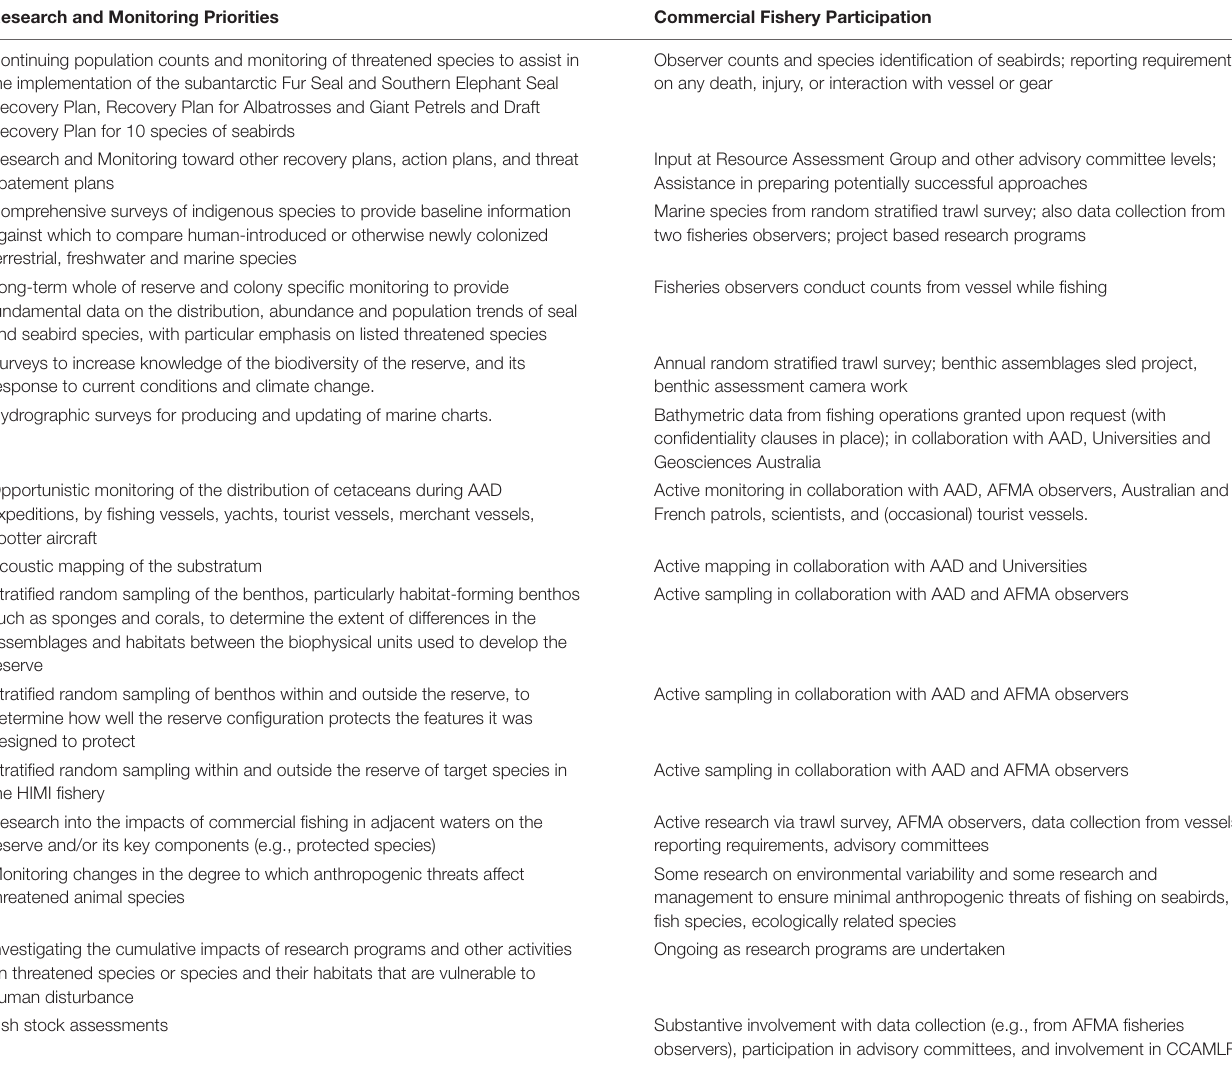
TABLE 3 | Participation of commercial fishery in marine reserve research and